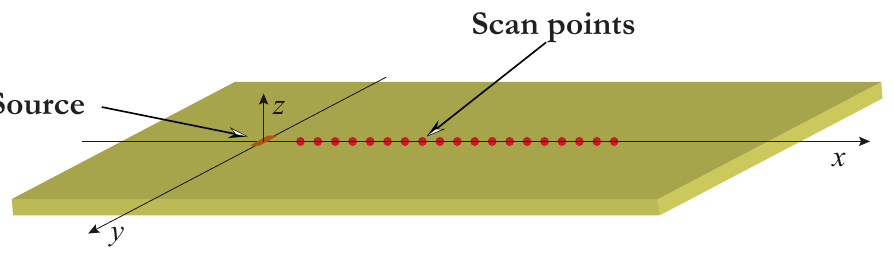
Figure 1. Geometry of the problem